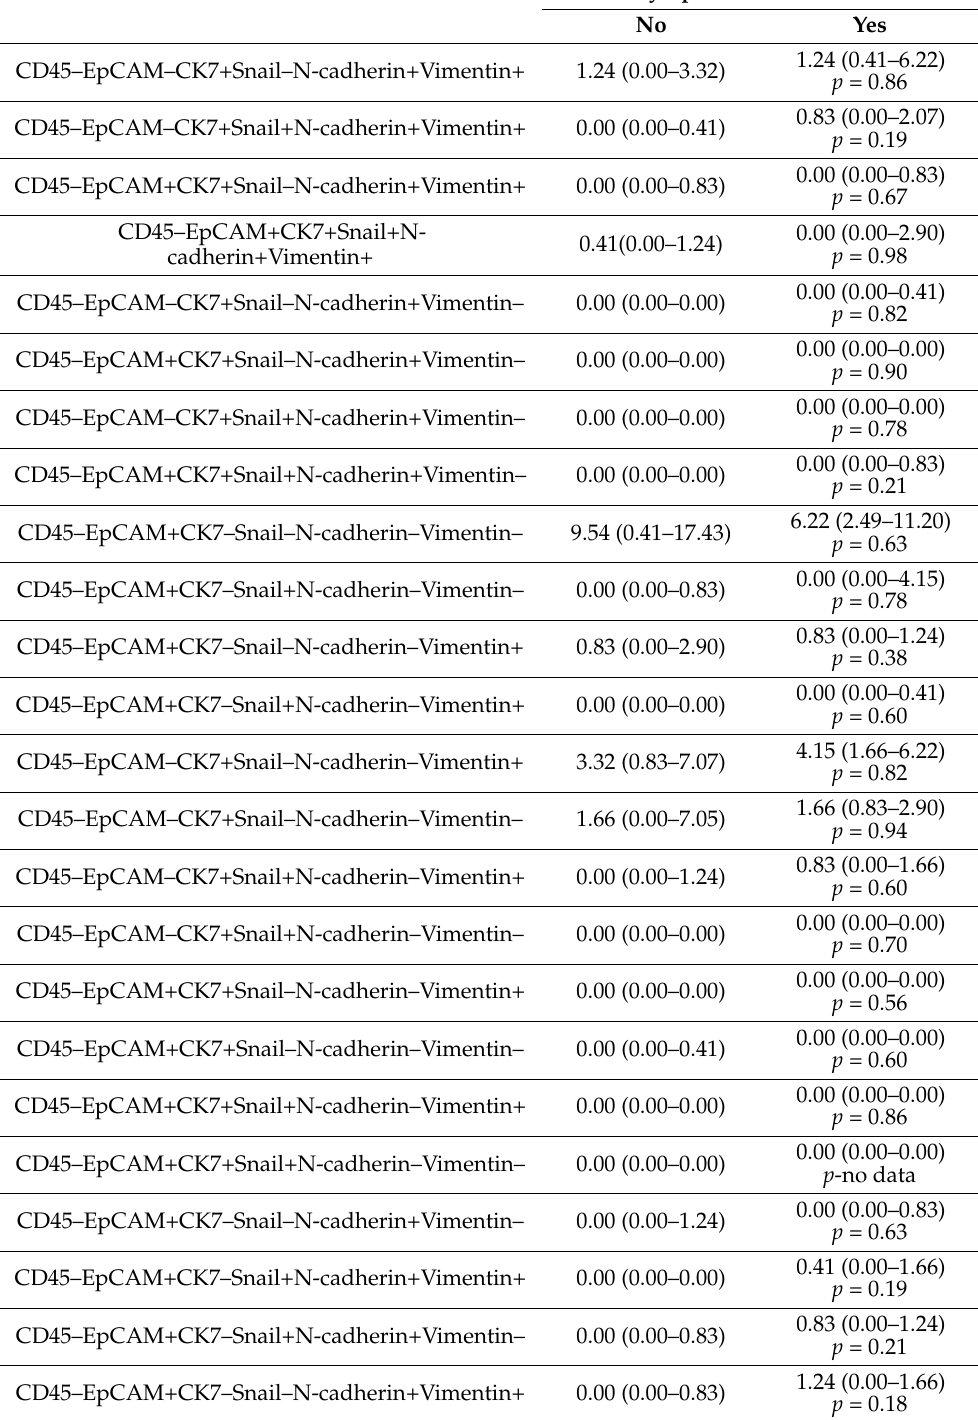
Table 4. The number of 24 studied CTC phenotypes in groups of patients with and without lym- phogenous